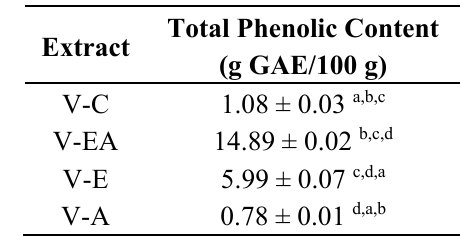
Table 2. Phenolic content of Vernonia kotschyana root